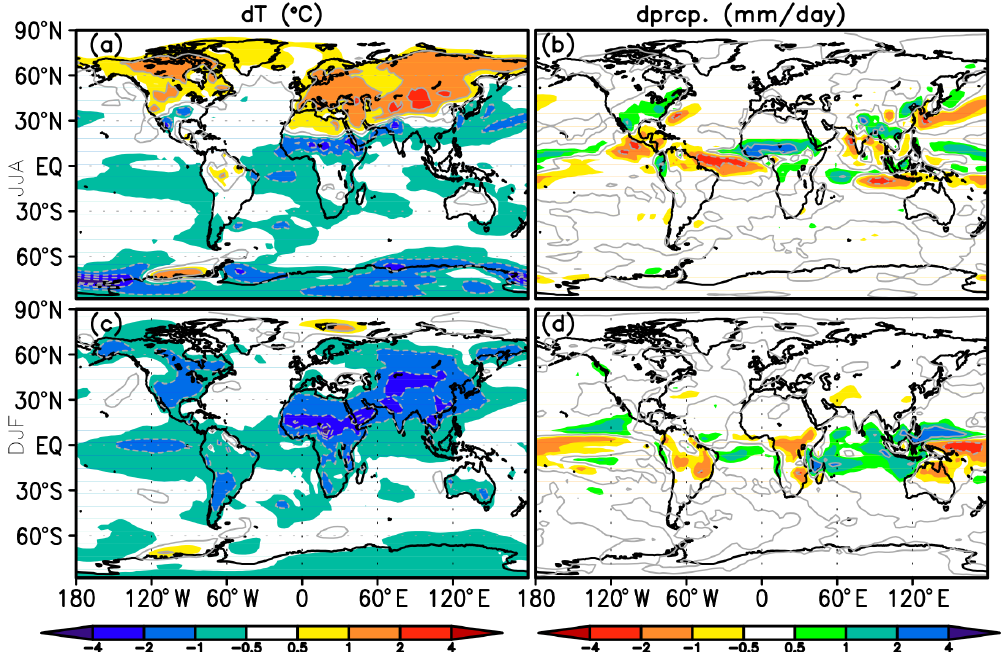
Figure 10. Seasonal temperature anomaly for (a) JJA and (c) DJF. Seasonal precipitation anomaly for (b) JJA and (d) DJF. Anomalies are calculated as 6ka relative to PI values. Calendar adjustments are applied.